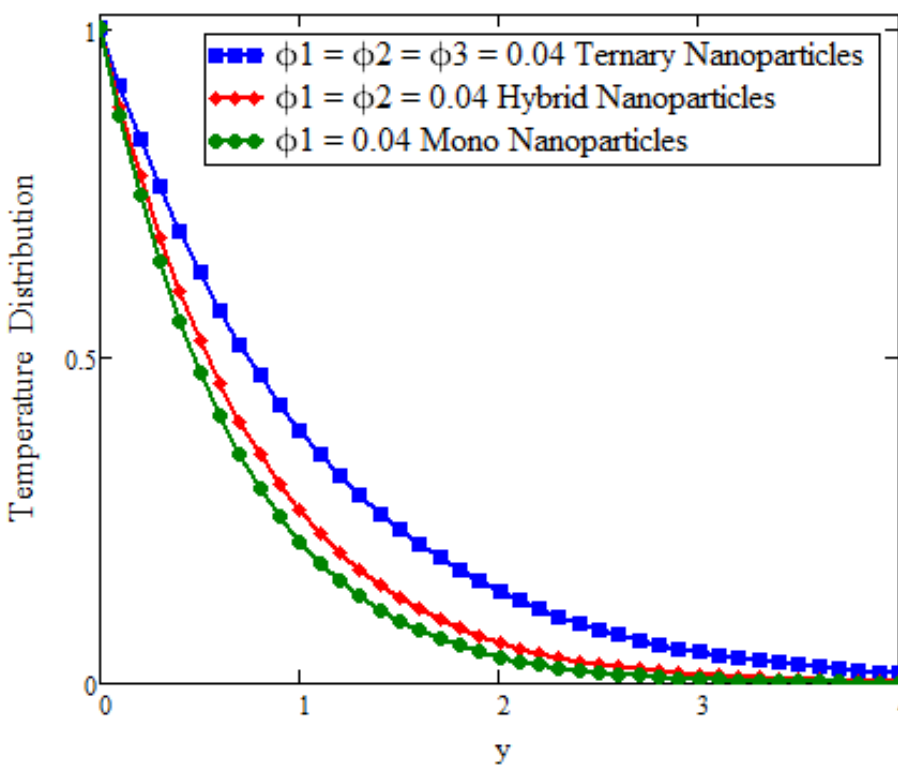
Figure 3. Comparison of temperature assessment across y as volume fraction φ 1 = φ 2 = φ 3 = 0.01 when α = β = γ = 0.5, t = 0.04, Sc = 1.5, and Pr =